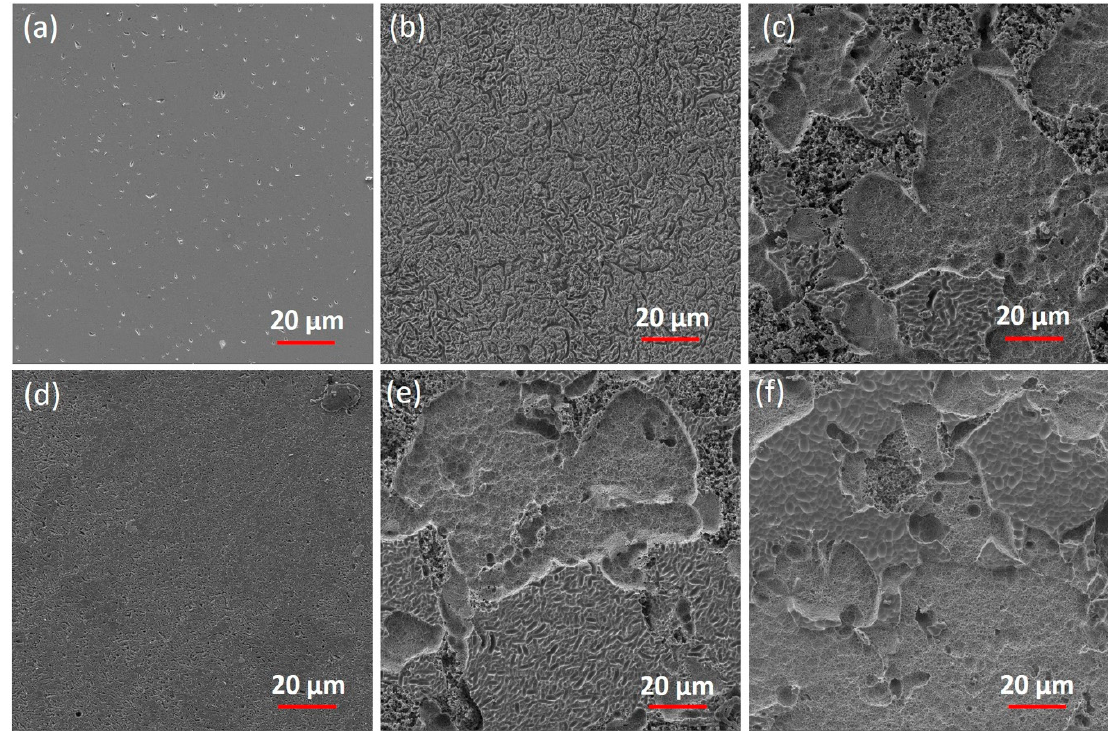
Figure 5. The SEM images of ( a ) reference (baseline) and corroded disks for 30 days of immersion in constant ( b ) pH 10, ( c ) pH 2, ( d ) pH 7, and ( e ) 3-d cycling and ( f ) 1-d cycling.